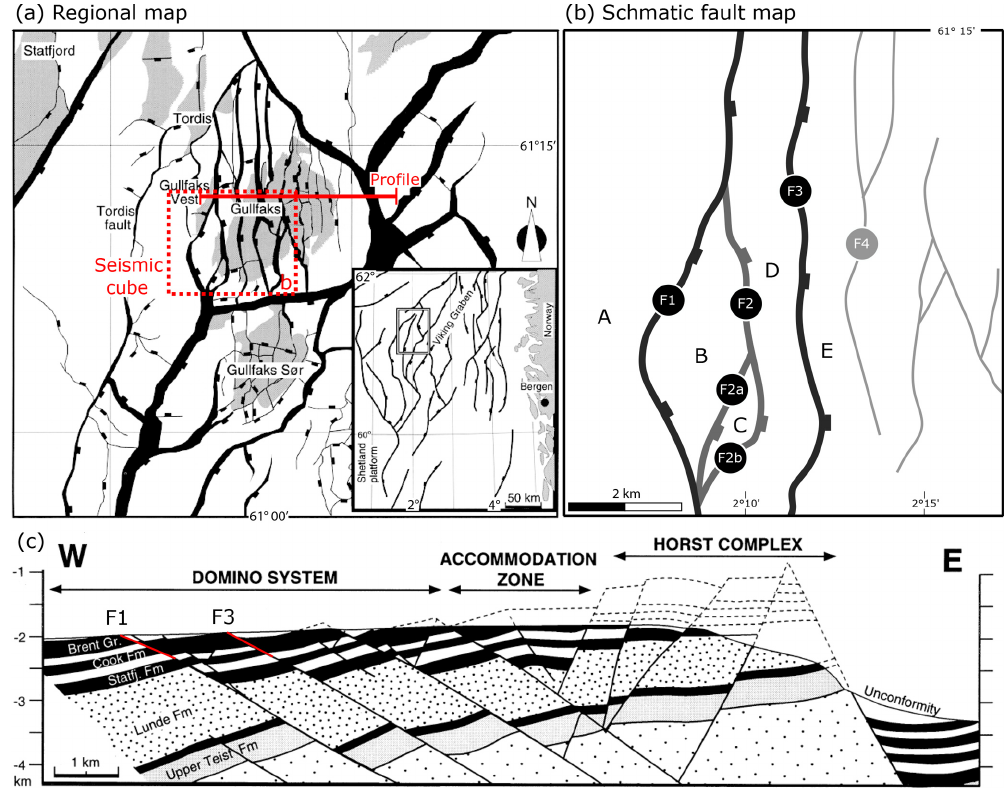
Figure 1. (a) Regional overview of the Gullfaks–Statfjord area located in the northern North Sea, showing the location of the Gullfaks oil field. (b) Fault map of the Statfjord Formation, showing the main faults of the Gullfaks field and their labeling. (c) Cross-section across the Gullfaks field, depicting the three distinct structural domains, major faults and stratigraphy (modified from Fossen and Hesthammer, 1998).